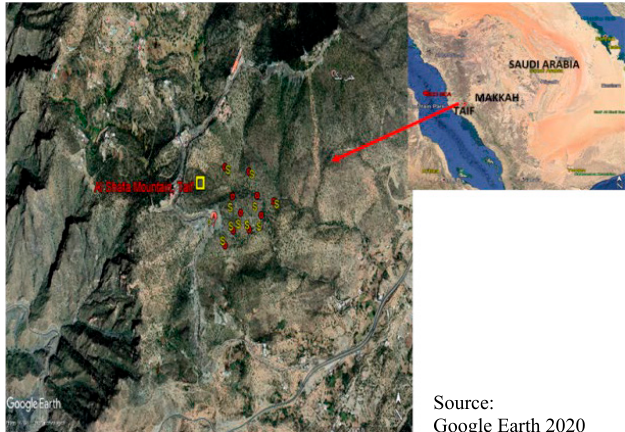
Fig. 1: Map of Shafa Mountains showing the sampling